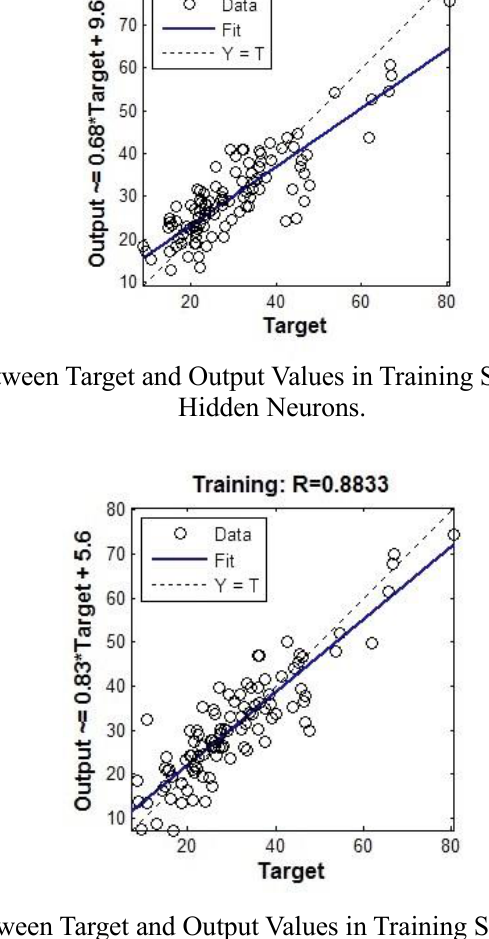
Fig. 12. Relationship between Target and Output Values in Training Step of ANN Modeling with 12 Hidden